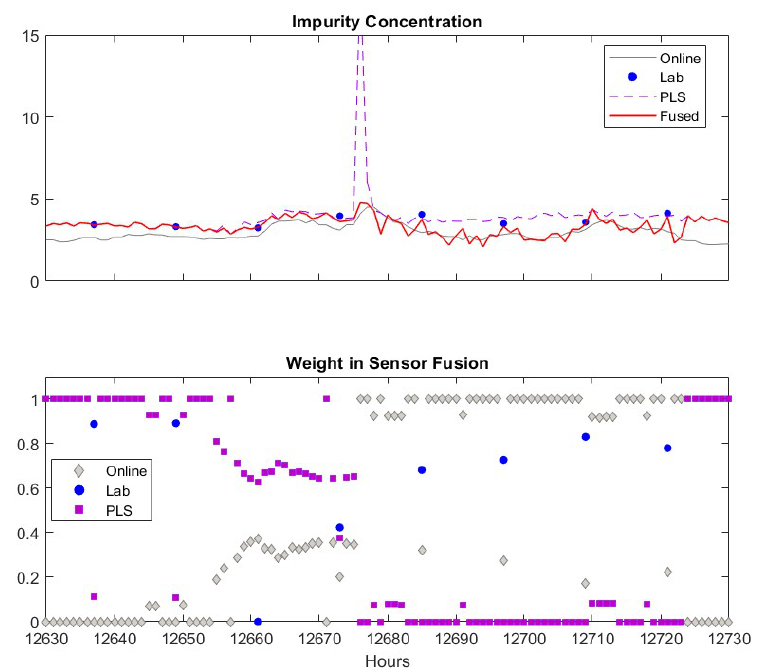
Figure 9. An example when PLS software sensor provides spurious data. Upper figure: Comparisons of lab data (●), online analyzer data ( ─ ), PLS software sensor data (--) and fused value ( ─ ). Lower figure: Weights of lab data (●), online analyzer data ( ♦ ), PLS software sensor data ( ■ ).